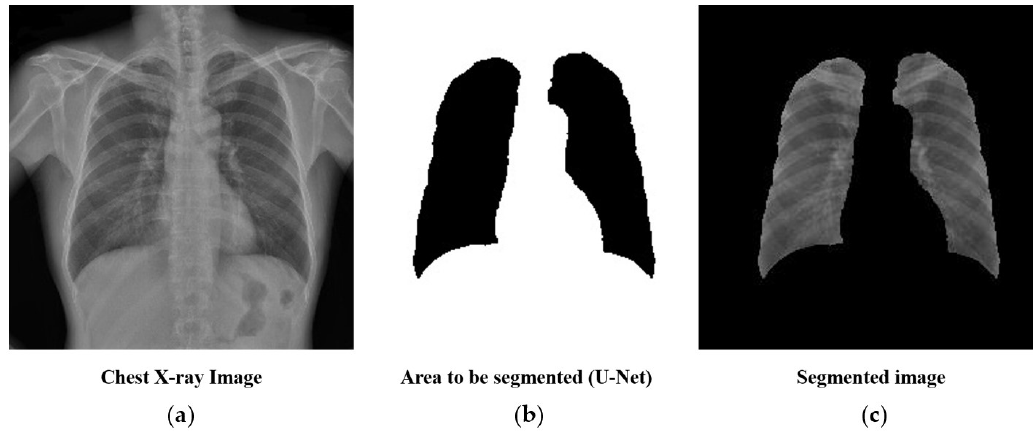
Figure 1. Lung segmentation using U-Net before training the convolutional neural network: ( a ) the original chest X-ray image, ( b ) a mask of lung structures segmented through U-Net, and ( c ) the final segmented image of the